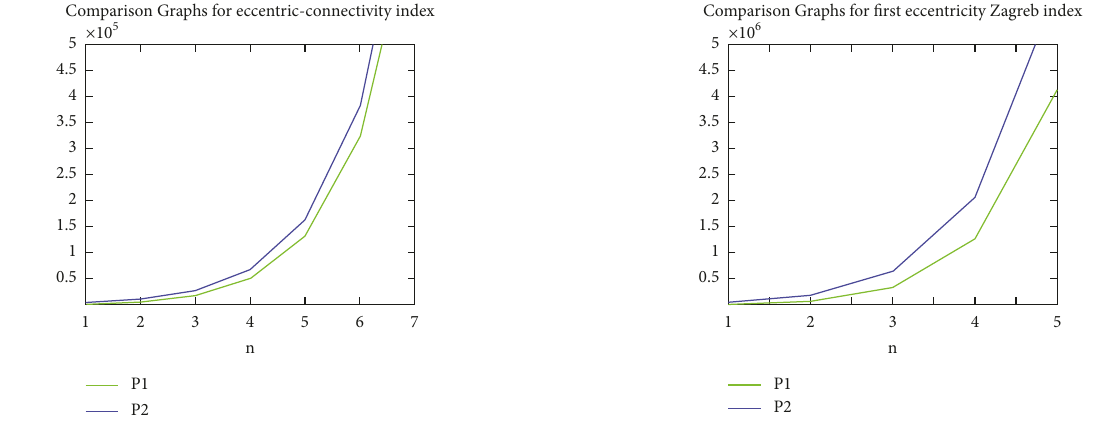
Figure 6: Graphical comparison between ZI of P n n and P 2 . 1 ( ) ( )